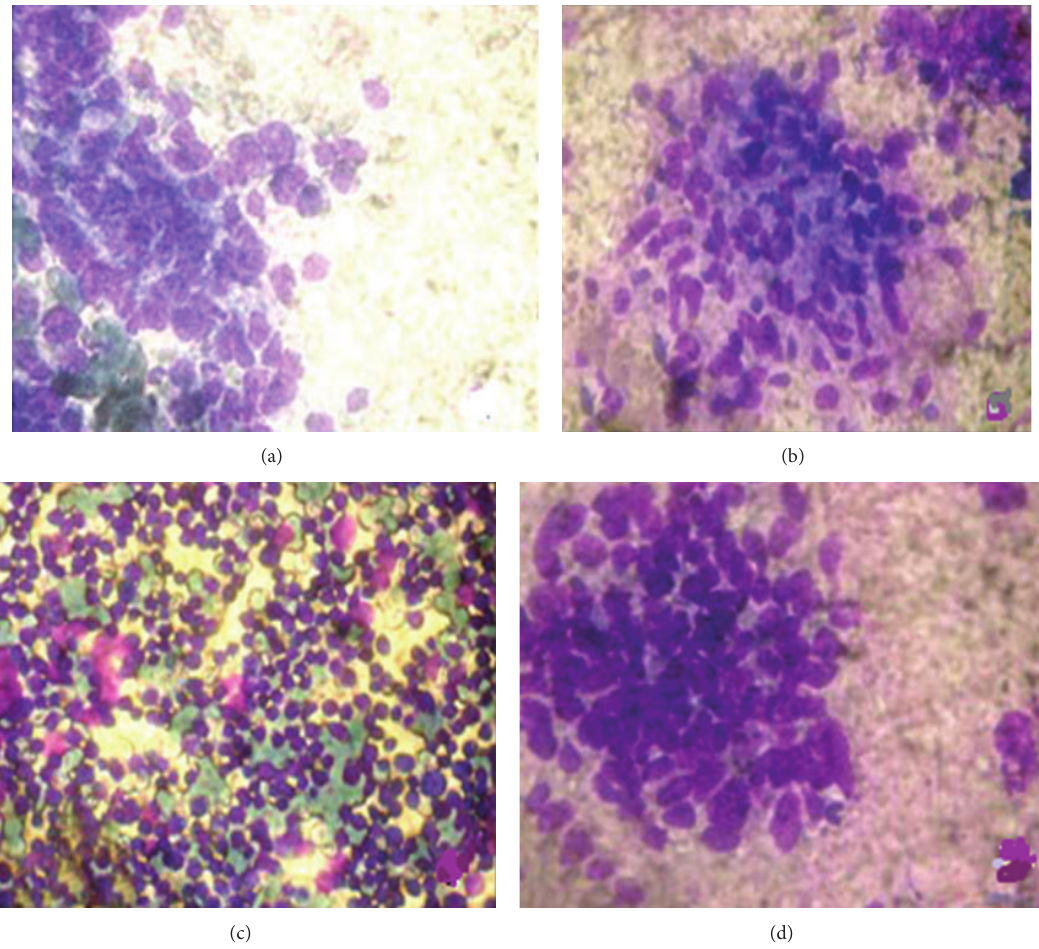
Figure 1: Cytomorphological appearances of various primary lung lesions. (a) Atypical cells of small cell carcinoma exhibiting nuclear moulding and smudging [MGG × 400]. (b) Epithelioid cell collections forming granuloma [MGG × 200]. (c) Monomorphic population of lymphoid cells in lymphoproliferative disorder [MGG × 200]. (d) Atypical cells forming gland pattern in adenocarcinoma [MGG ×